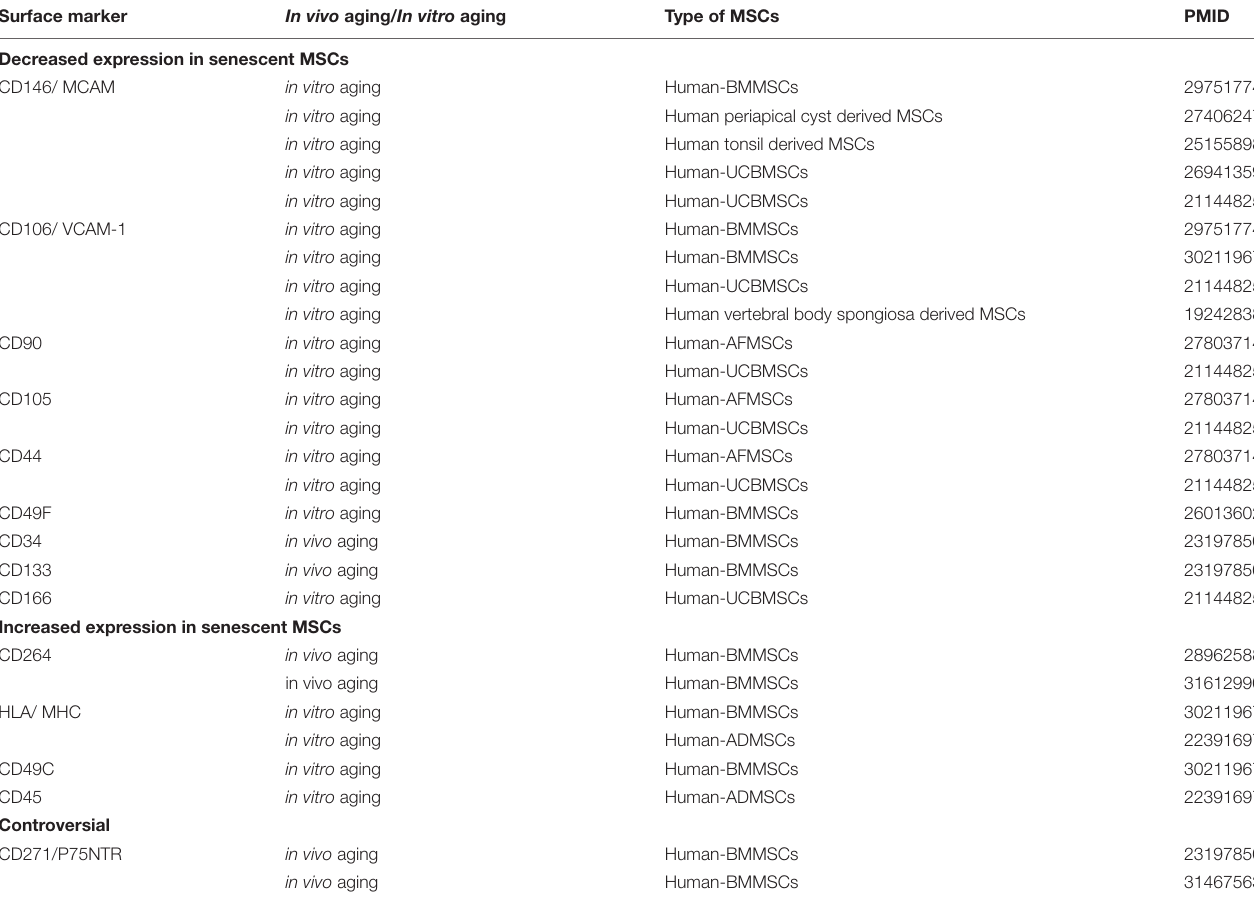
TABLE 2 | Surface marker alteration in senescent